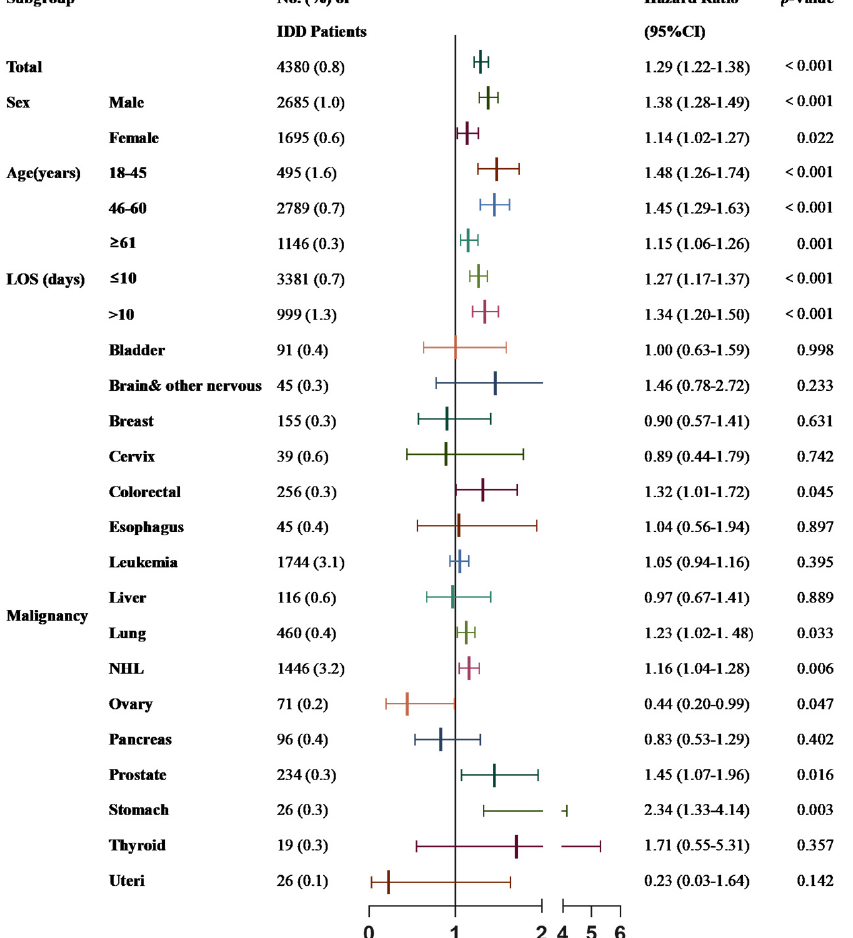
Figure 4. Subgroup analysis of 30-day unplanned readmission group (NOIDD ref. = 1). Analyses were adjusted for age, sex, body mass index, hypertension, diabetes, hyperlipidemia, severe hospitalization, location of residence, insurance type and household income.